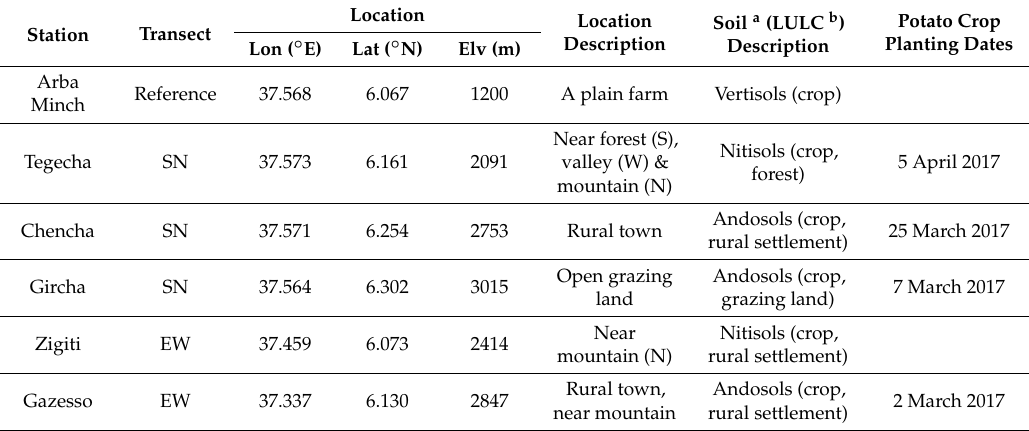
Table 1. Gamo Ethiopian Meteorological Stations (GEMS) and potato crop field experiment site descriptions. Key: Lon—longitude; Lat—latitude; Elv—elevation; LULC—land use land cover; N, E, S, W—north, east, south,